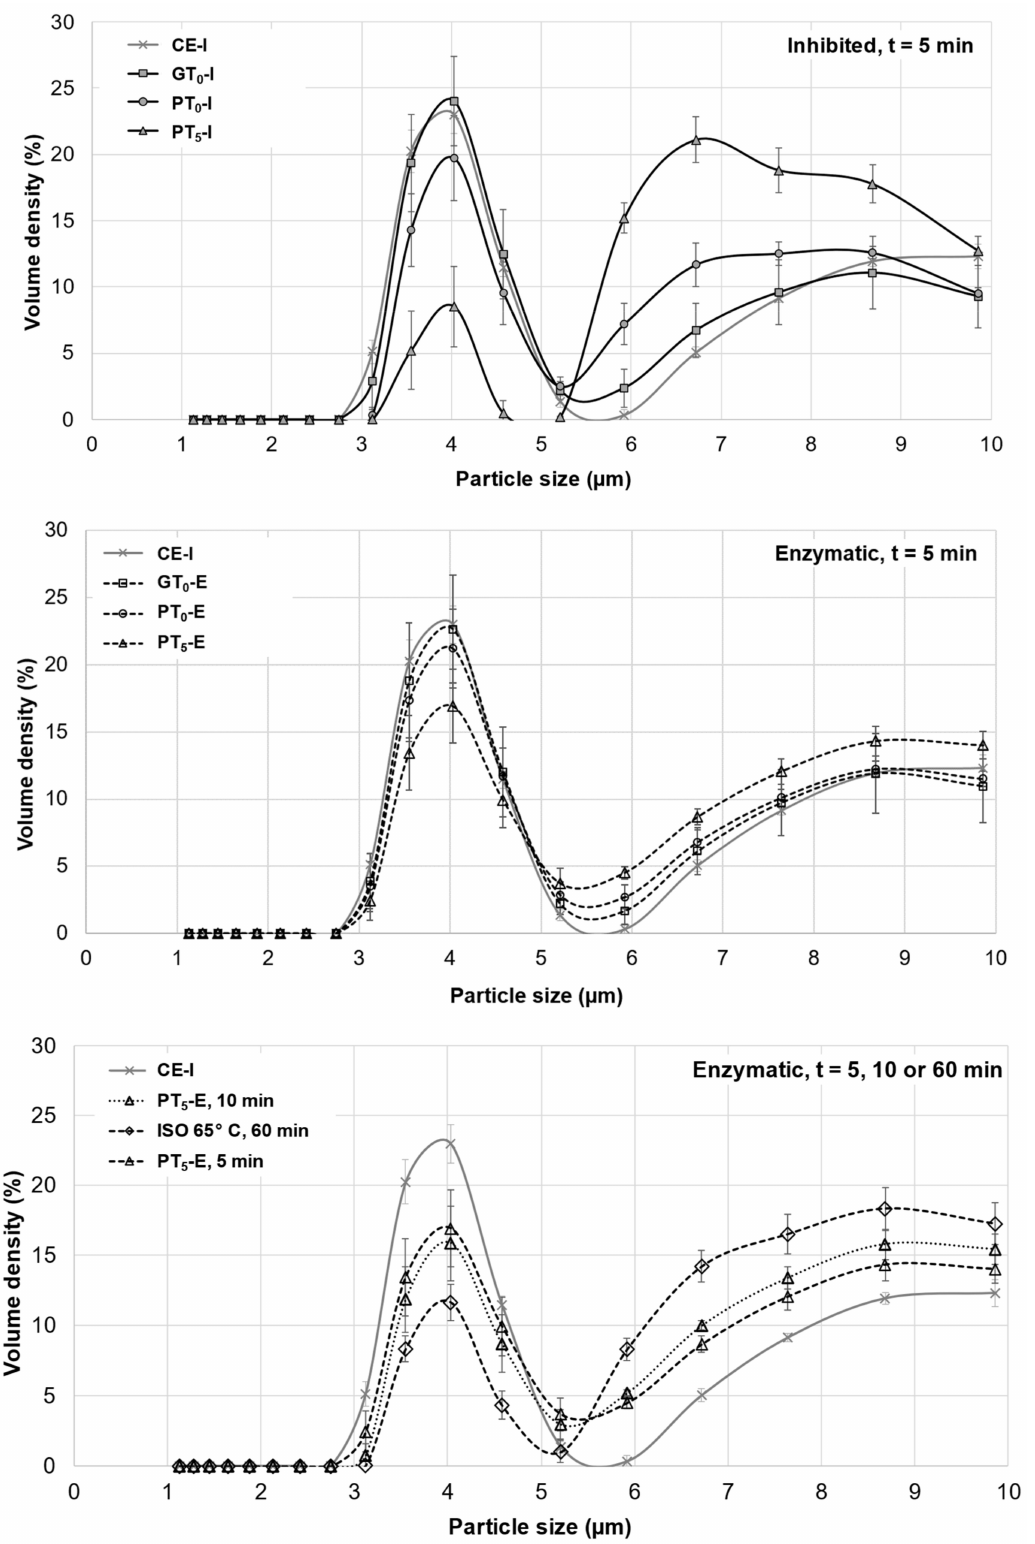
Figure 5. Averaged particle size distributions of B-type granules after mashing for 5 min at inhibited conditions, 5 min at enzymatic conditions and varying durations at enzymatic conditions. In all diagrams, CE-I is displayed as a reference. Data points refer to mean values ( N = 18), error bars represent the standard